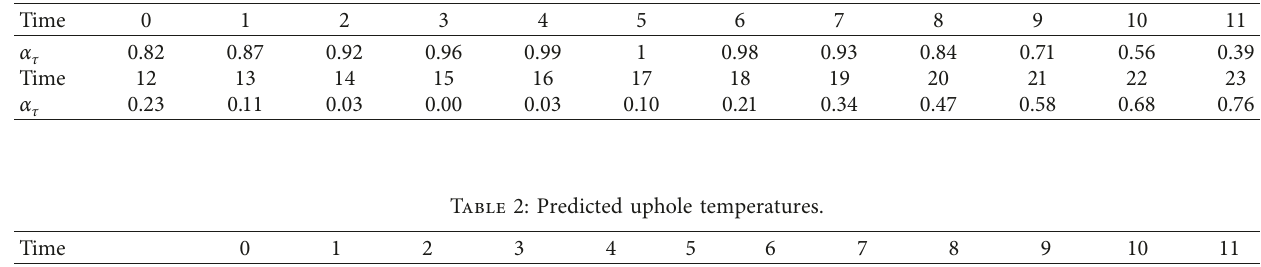
Figure 2: Flow chart for temperature and wind speed Table 1: Uphole temperature prediction parameters.